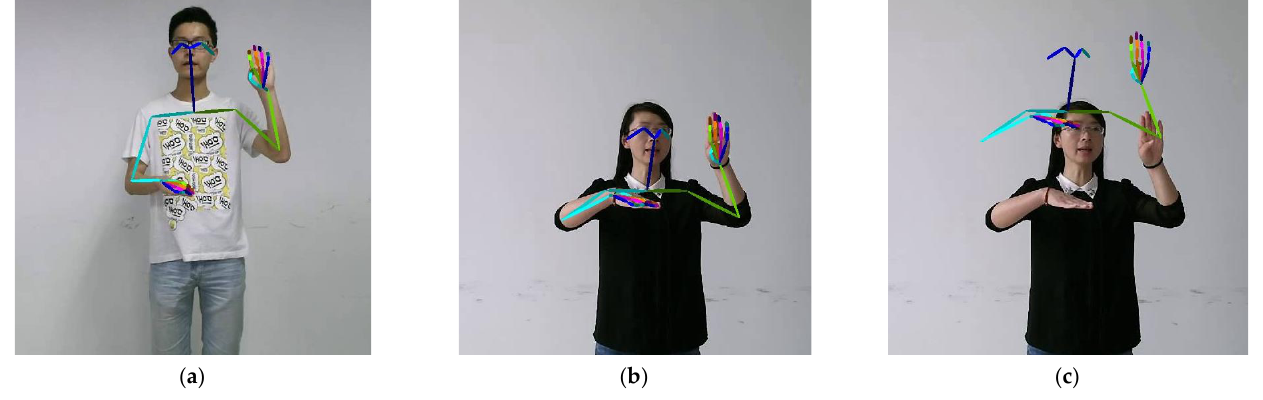
Figure 10. Skeleton data normalization example. ( a ) Benchmark sign language speaker; ( b ) Joints data before normalization; ( c ) Joints data after normalization.